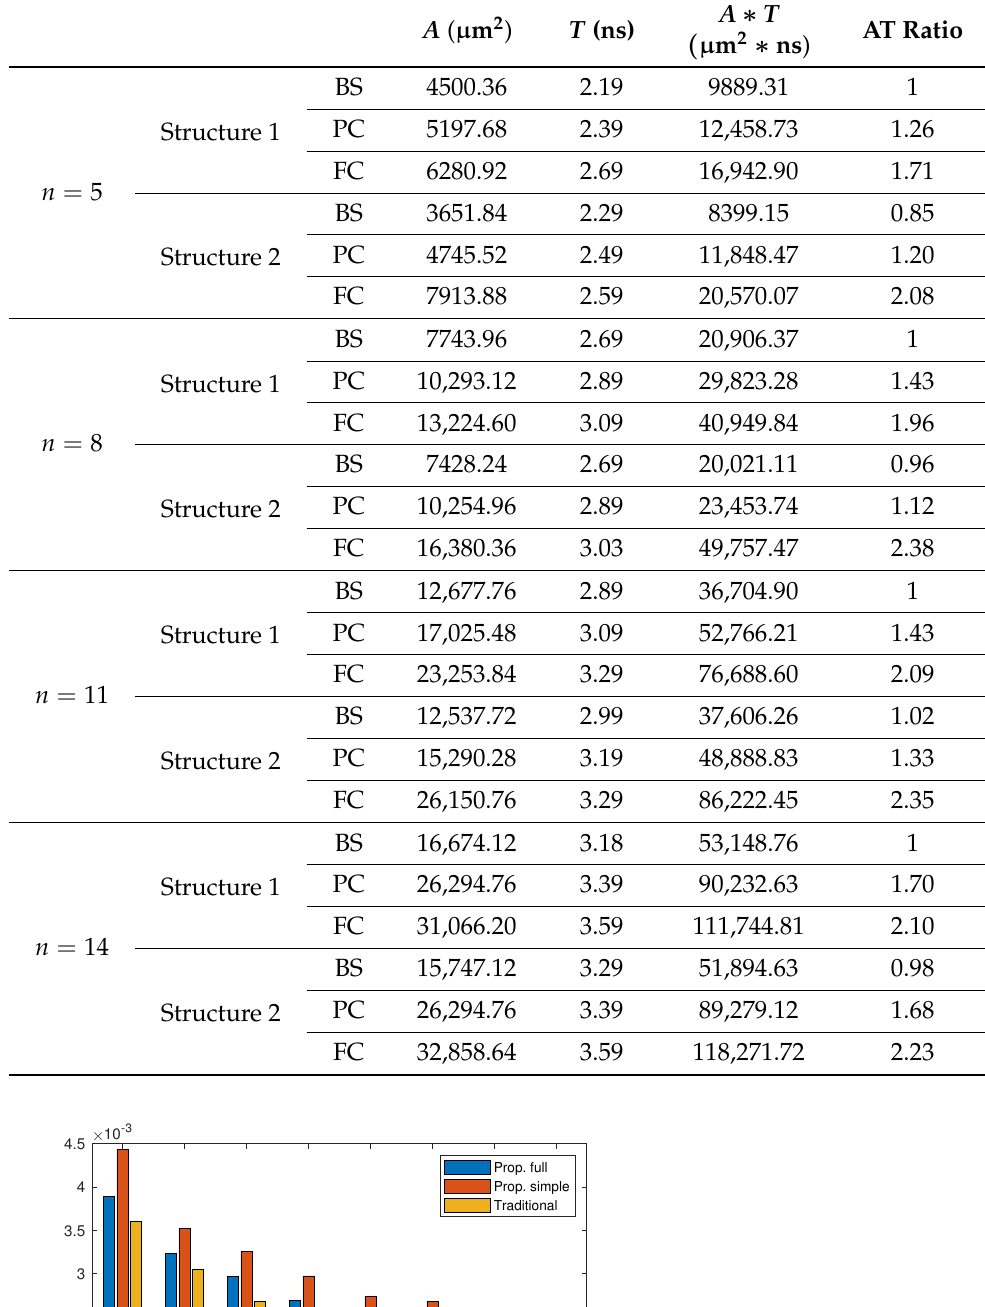
Table 3. Synthesis results of multipliers.